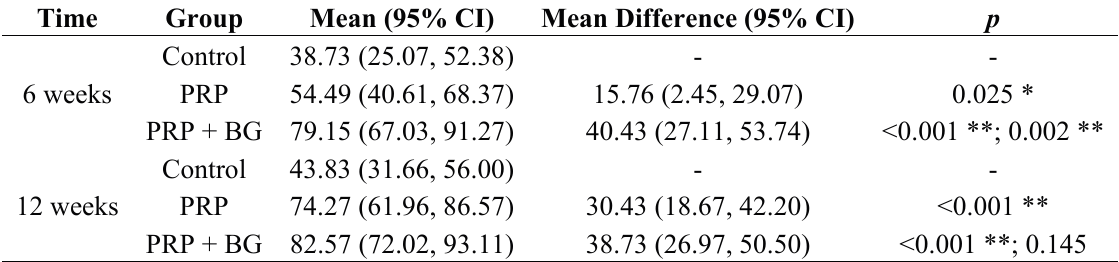
Table 1. Multiple comparisons of Mechanical Examination among groups at different